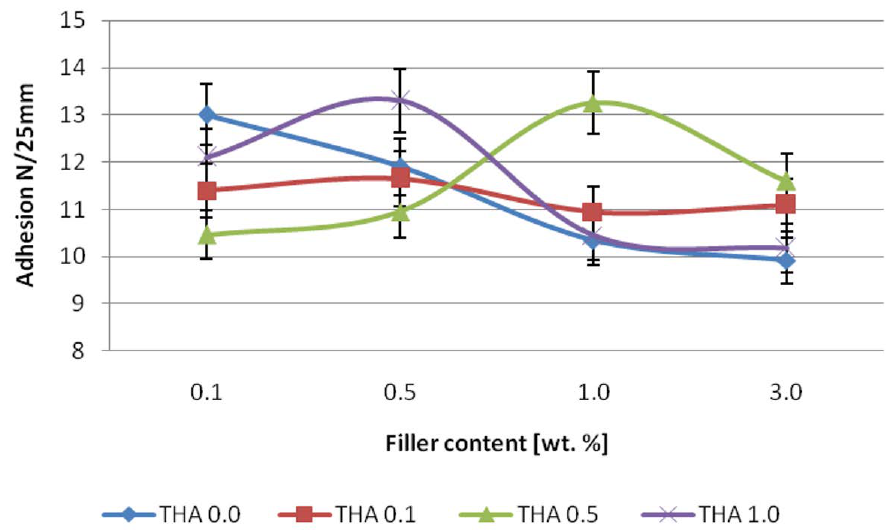
Figure 4. Effect of neat and modified illite content on the peel adhesion of silicone pressure- sensitive adhesive.